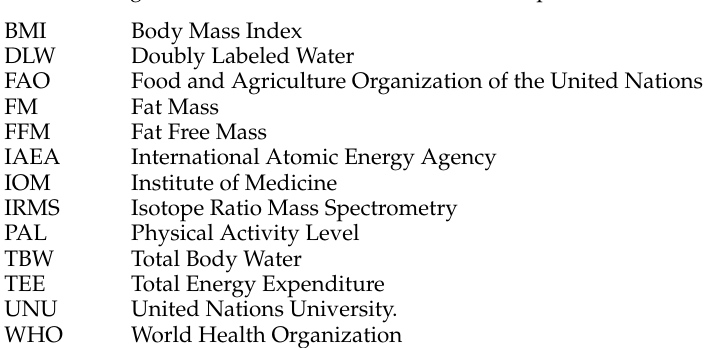
Table S1: Identification number, gender, age, body weight, body height, body mass index (BMI) and BMI for age z-score at baseline; Table S2: Identification number, gender, age, body weight, body height, body mass index (BMI) and BMI for age z-score at Day 14; Table S3: Identification number, gender, total body water (TBW), fat free mass (FFM) and fat mass (FM); Table S4: Identification number, gender and total energy expenditure (TEE) based on 14 days data collection, resting energy expenditure (REE), activity energy expenditure (AEE) and physical activity level (PAL); Table S5: Identification Number, Gender and Total Energy Expenditure (TEE) Based on the First 7 days and the Complete 14 days